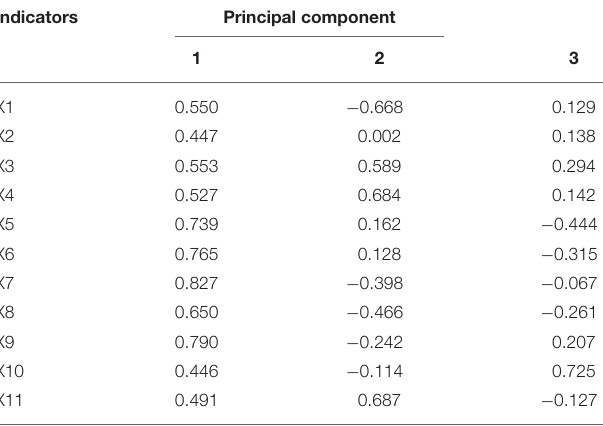
TABLE 2 | Initial unrotated factor loading